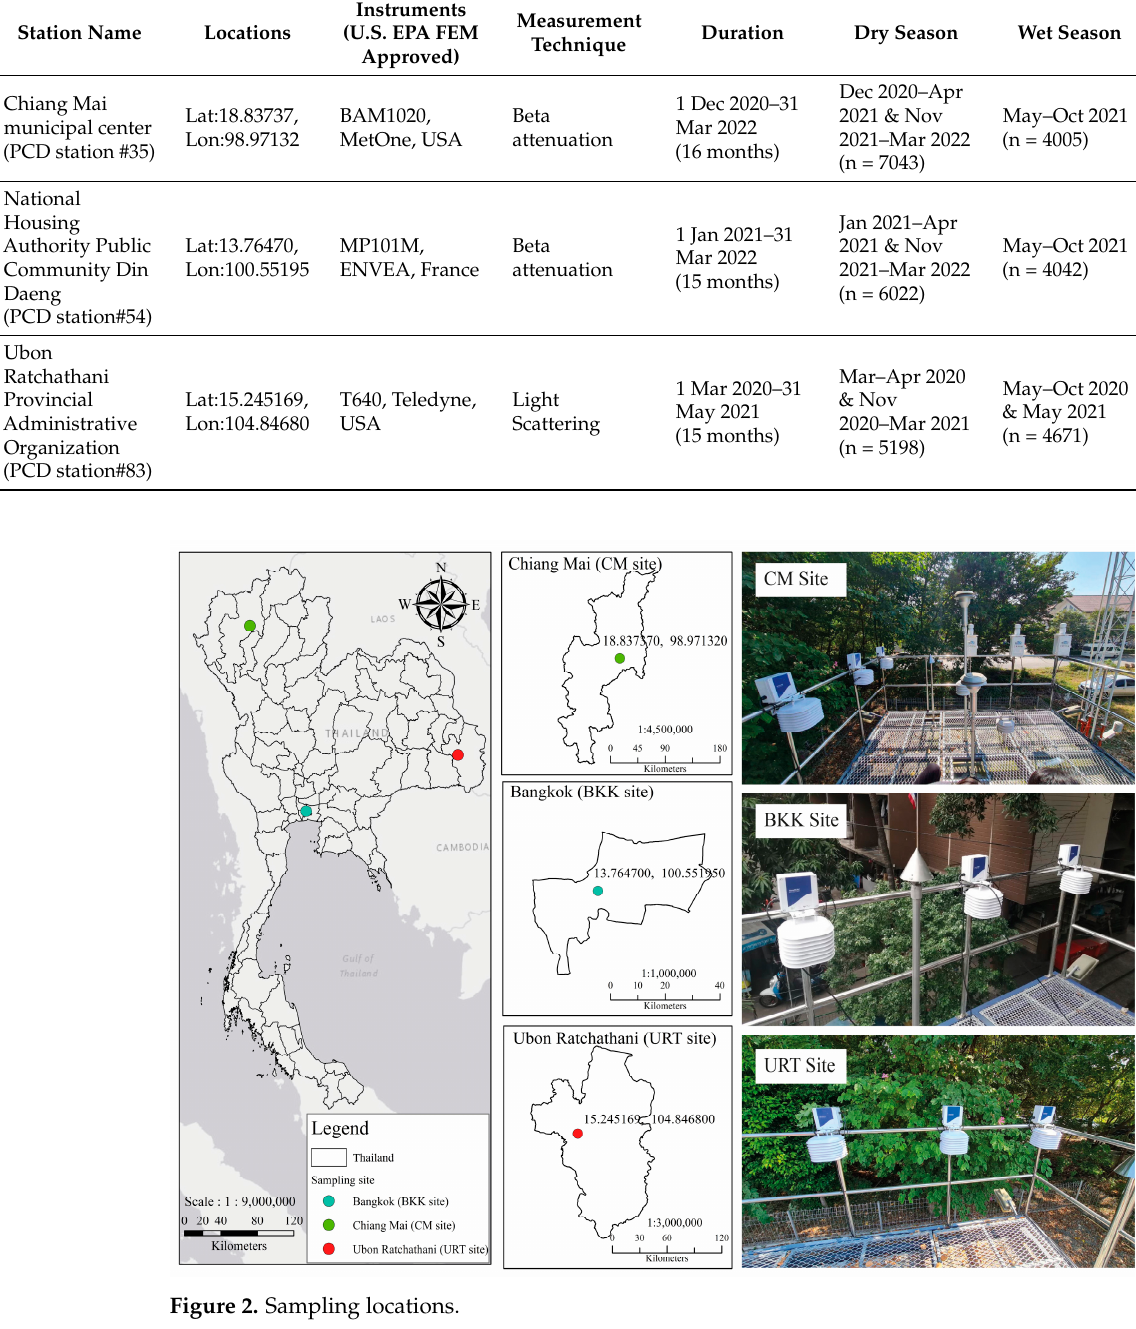
Figure 2. Sampling